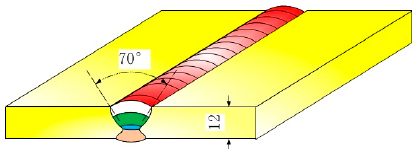
Figure 1. Schematic diagram of the multipass weld bead (mm). Table 1. Chemical composition (wt. %) of base metal and welding rod.